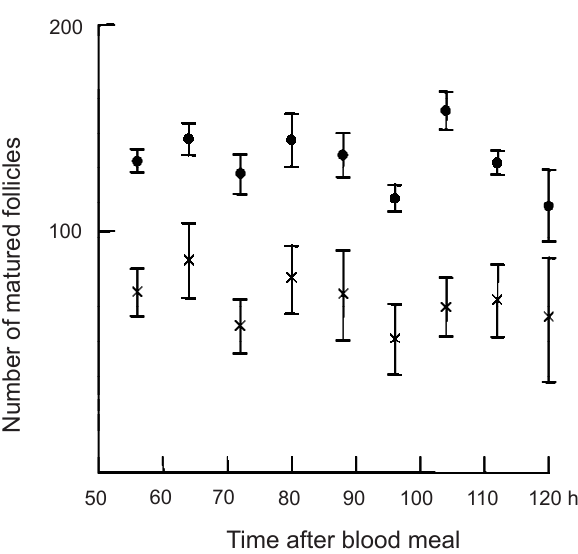
Fig. 1. – First experiment: means and standard errors of the matured follicle numbers according to time after the blood meal for replete ( ● ) and interrupted ( ✕ ) females. The number of matured follicles was counted only from stage V on (the first stage V was observed 56 h after the blood meal).